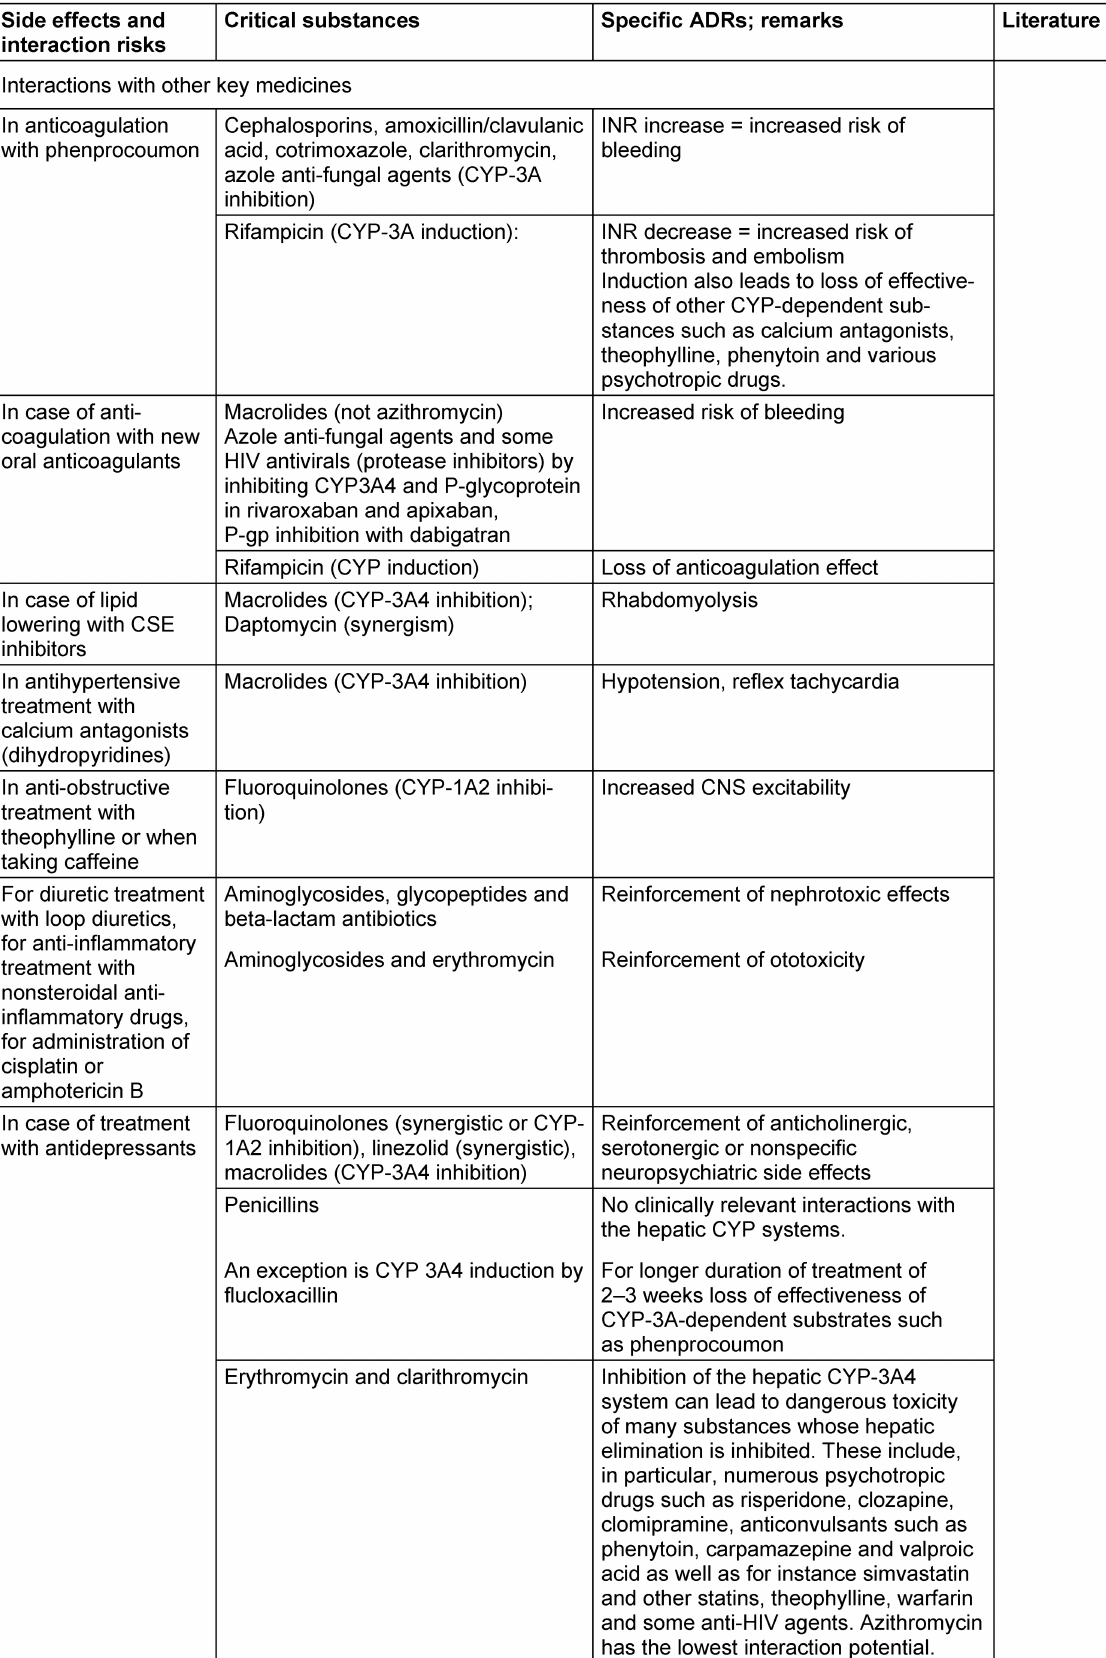
Table 3: Evaluation of the individual antibiotic classes or individual substances according to side effects and risk of